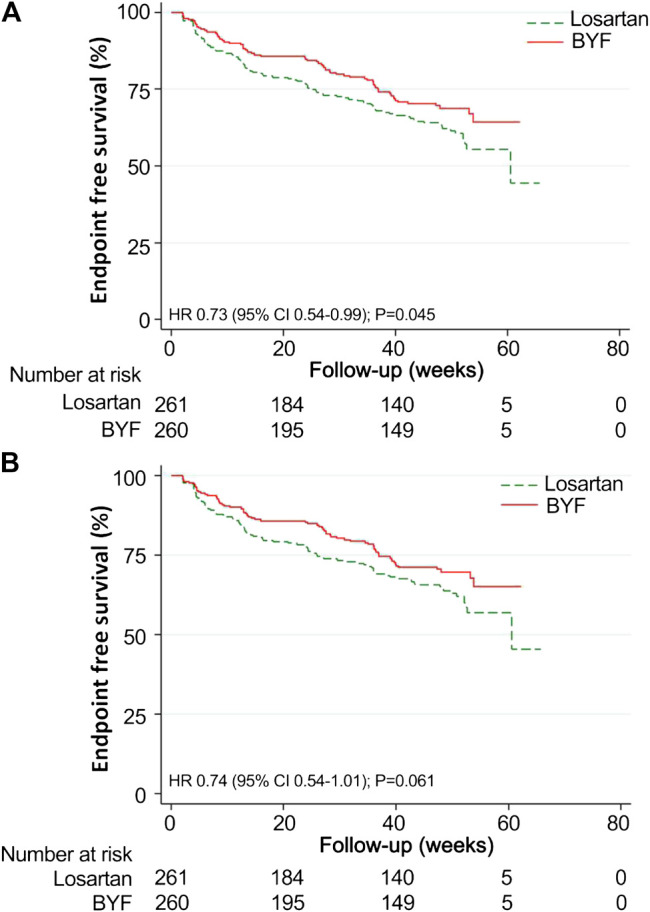
Kaplan-Meier survival curves for the Bupi Yishen Formula (BYF) and Losartan groups. Twenty-eight participants were excluded from the survival analyses as they reached end-stage kidney disease (ESKD) after randomization but before the initiation of treatment. (A) Composite endpoint (composite of death, doubled serum creatinine, ESKD, and cardiovascular or cerebrovascular events). (B) ESKD.